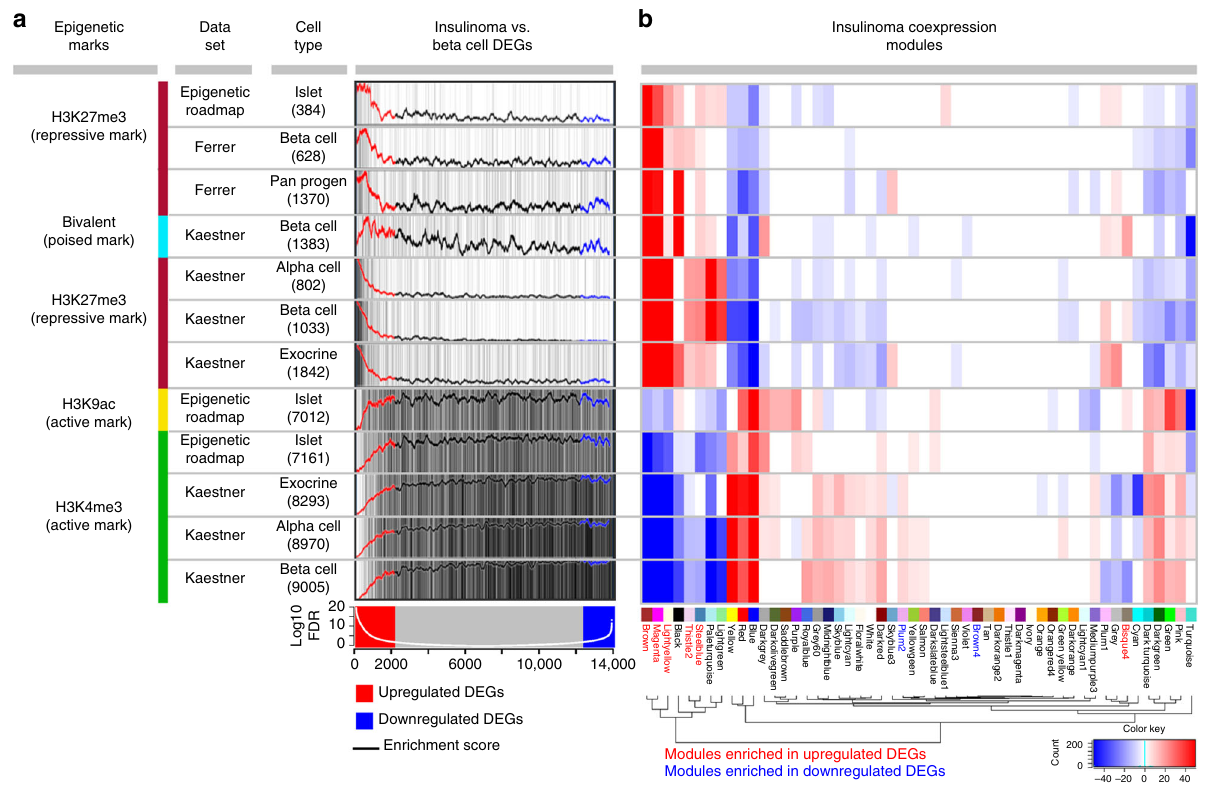
Over-enrichment: log2(FDR)